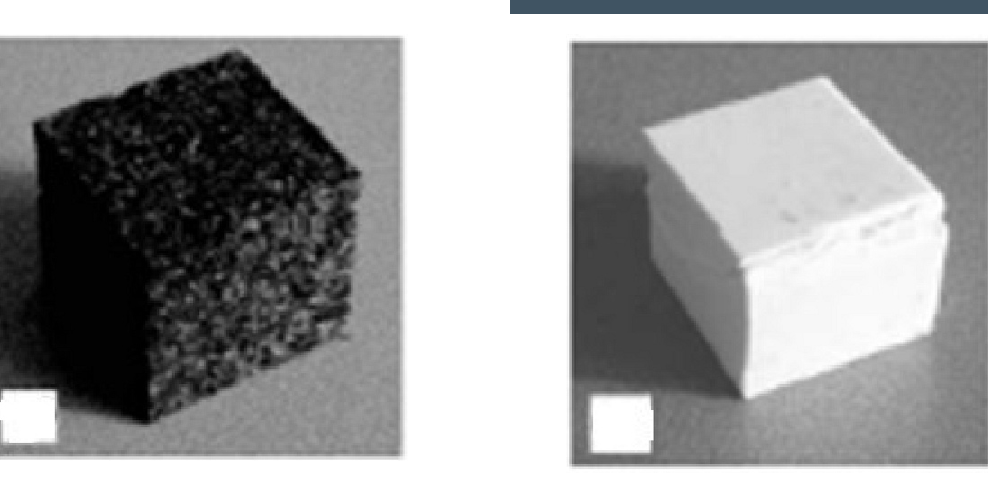
Figure 3. PUR specimen in quasi-static tests.